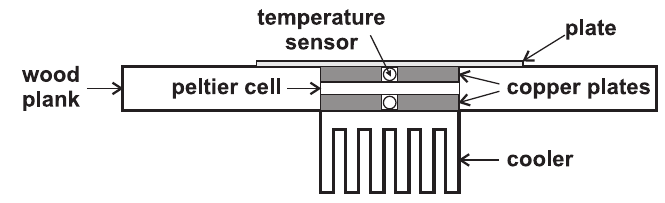
Figure 4. Layout of the first experimental measurement.